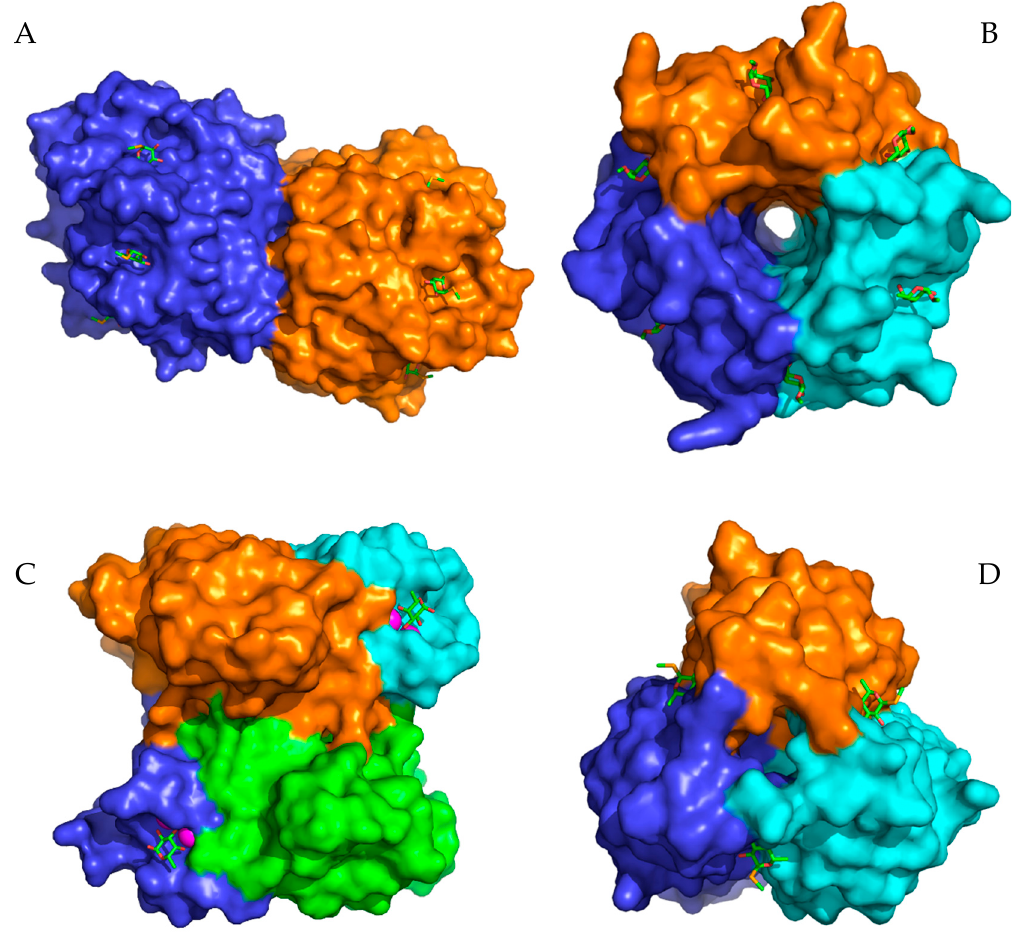
Figure 1. Structures of selected lectins from pathogenic microorganisms used for the inhibition studies. ( A ) AFL dimer in a complex with seleno fucopyranoside (PDB 4AGI). ( B ) RSL trimer in a complex with methyl α - l -fucopyranoside (PDB 2BT9). ( C ) PA-IIL tetramer in a complex with α - l -fucopyranoside (PDB 1UZV). ( D ) Trimer of the BC2L-C N-terminal domain in a complex with seleno fucopyranoside (PDB 2WQ4). Carbohydrates in the binding sites are depicted as sticks. The magenta spheres represent calcium ions in the binding sites of lectin PA-IIL.